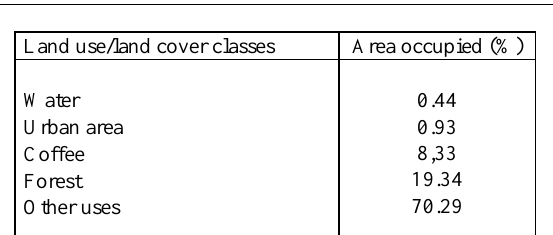
Figure 2. Land use/land cover map of the IG Mantiqueira de Minas.